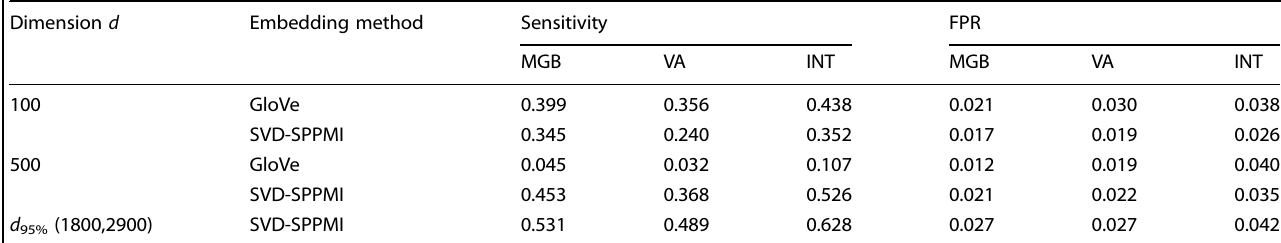
Table 2. Sensitivity and FPR of KESER MGB (MGB), KESER VA (VA), and KESER INT (INT) in detecting known related pairs using embedding vectors trained via SVD-SPPMI or GloVe at different dimensions d . Dimension